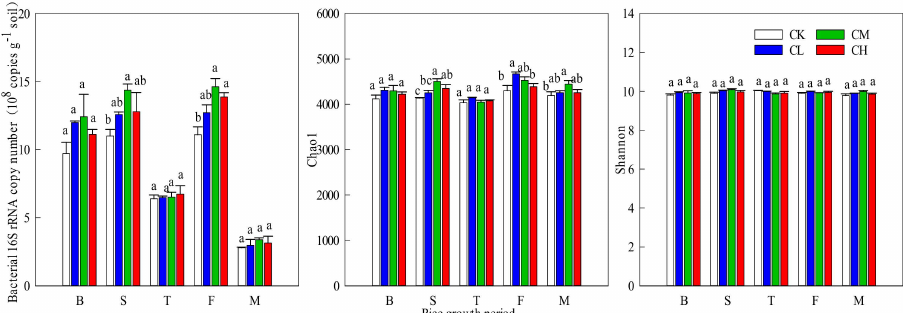
Figure 5. Dynamics of the copy number of soil bacteria and alpha diversity under different fertiliza- tion treatments during the different rice growth stages. Note: CK: chemical fertilizer, CL: the low amount of CMV, CM: the medium amount of CMV, CH: the high amount of CMV, B: background soil, S: seedling stage, T: tillering stage, F: flowering stage, M: maturity stage. The error line indicates a standard error (n = 3). Lowercase letters represent significant differences between treatments ( p < 0.05, Duncan test).